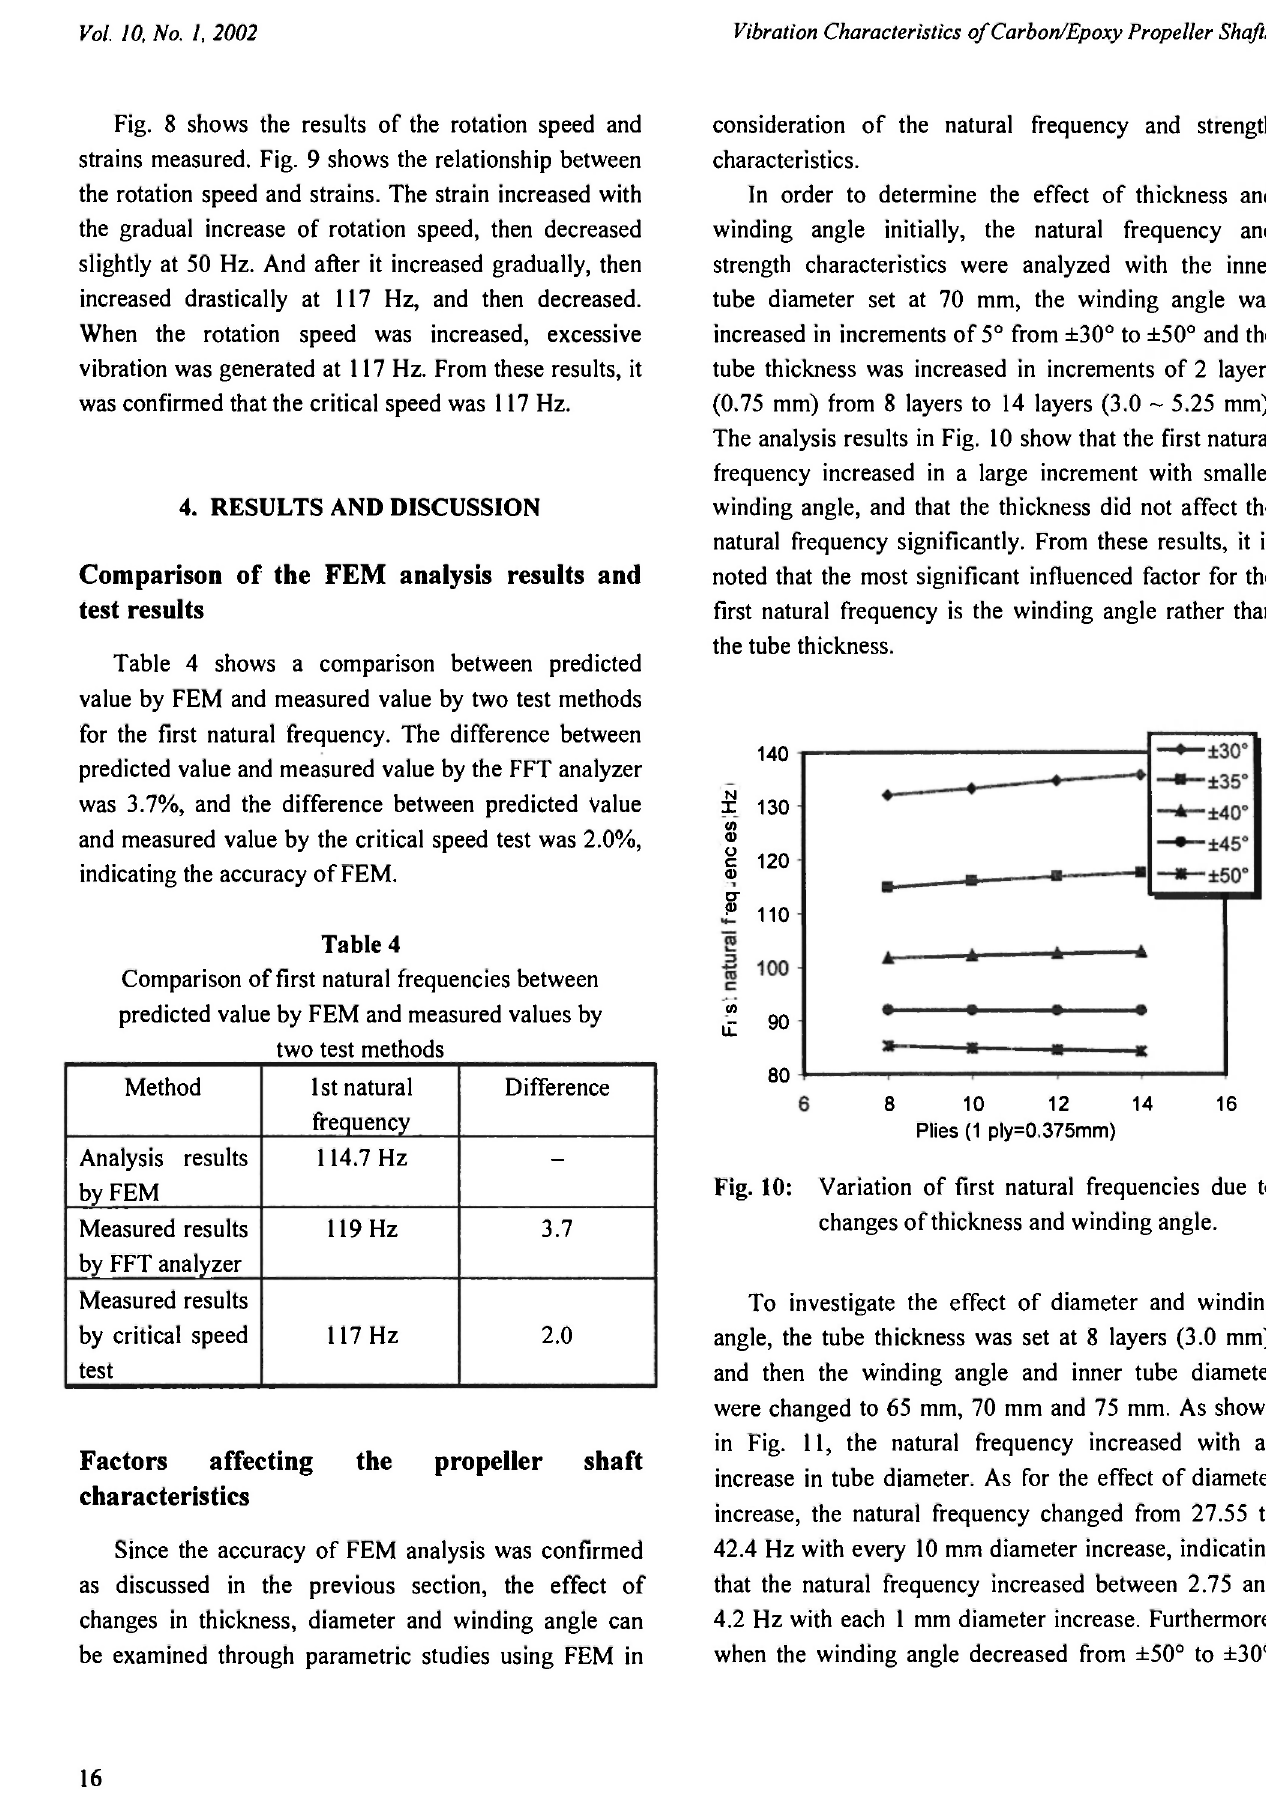
Variation of first natural frequencies due to changes of thickness and winding